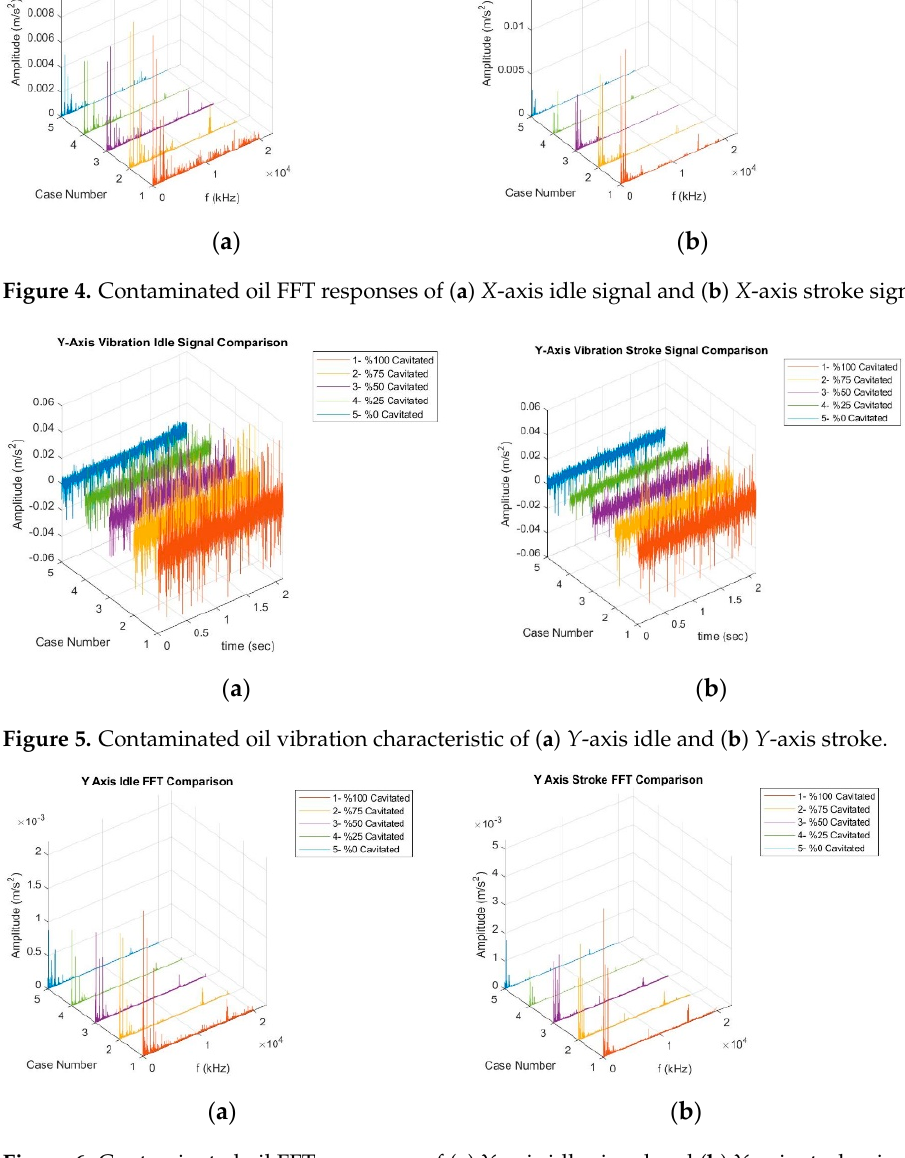
Figure 6. Contaminated oil FFT responses of ( a ) Y-axis idle signal and ( b ) Y-axis stroke signal.